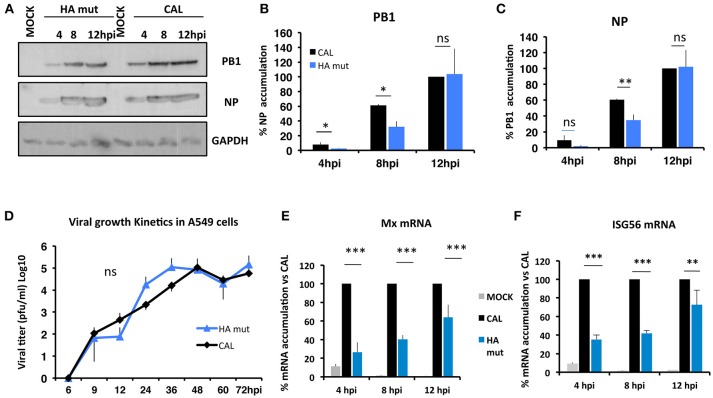
Growth kinetics of CAL and HA mut viruses. (A) Cultured human lung epithelial cells (A549) were infected with CAL and HA mut viruses 3 pfu/cell. At the indicated times, aliquots were used for Western blot assays to detect PB1, NP, and GAPDH proteins. The experiment was performed in triplicates and one representative data is shown. (B,C) show quantification and significance analysis of triplicates. Data are shown as % related to maximum accumulation of viral proteins in CAL virus infected cells. Values shown as means and error bars indicate mean ± SD of three independent experiments (ns Not significant, *p < 0.05, **p < 0.01 by t-Student test). (D) A549 cells were infected at 10−3 pfu/cell, at the indicated times, aliquots were taken and used for titration on MDCK cells. The experiments was repeated three times and significance was determined by two-way ANOVA with Bonferroni post-hoc test, (ns) not significant. (E) Cultured human lung epithelial cells (A549) were mock infected or infected with CAL, or HA mut virus stocks at moi 0.5. At indicated hours post-infection (hpi), samples were used to evaluate Mx mRNA (E) or ISG56 mRNA (F) by q-PCR. Data are shown as % of mRNA accumulation in CAL infected cells at each time tested. Quantification and significance analysis of triplicates are shown as means and error bars indicate ± SD (**p < 0.01, ***p < 0.001 by t-Student test).